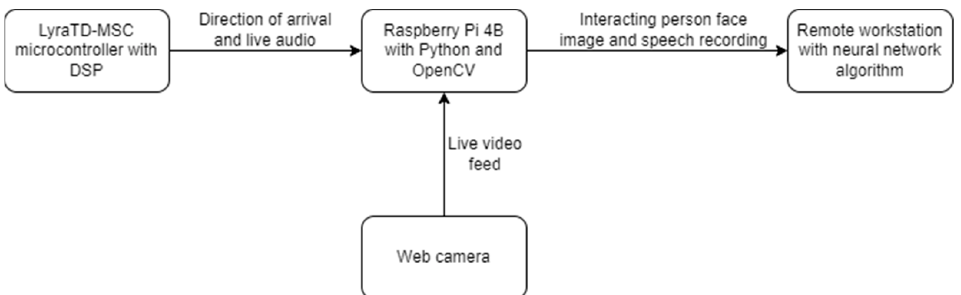
Figure 3. System architecture.